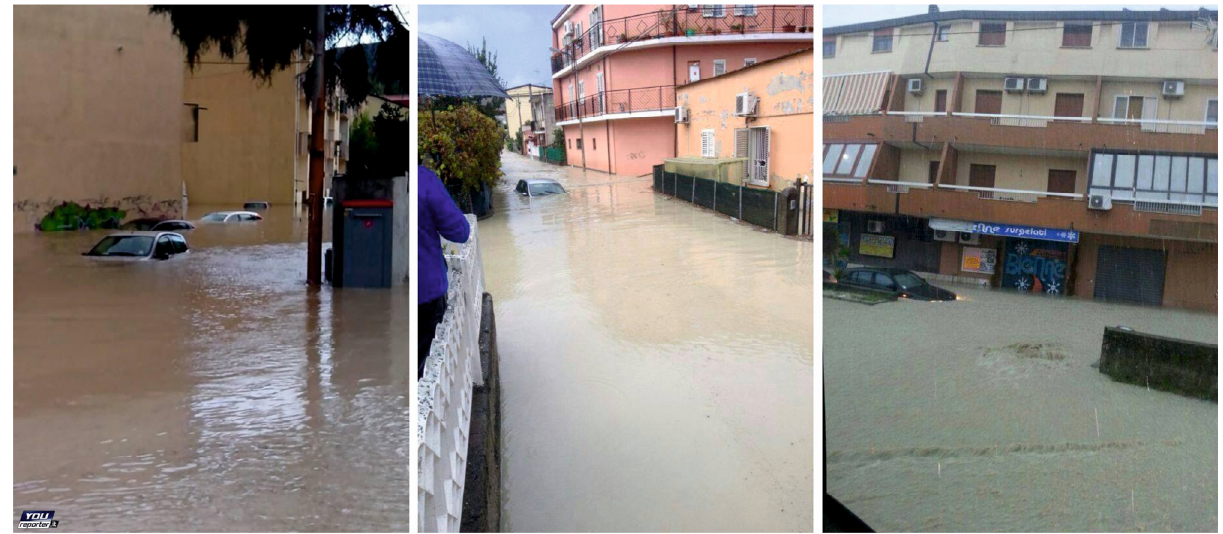
Figure 4. Catanzaro town on 19 November 2014. Cars partially submerged by the floodwaters that overflowed from local